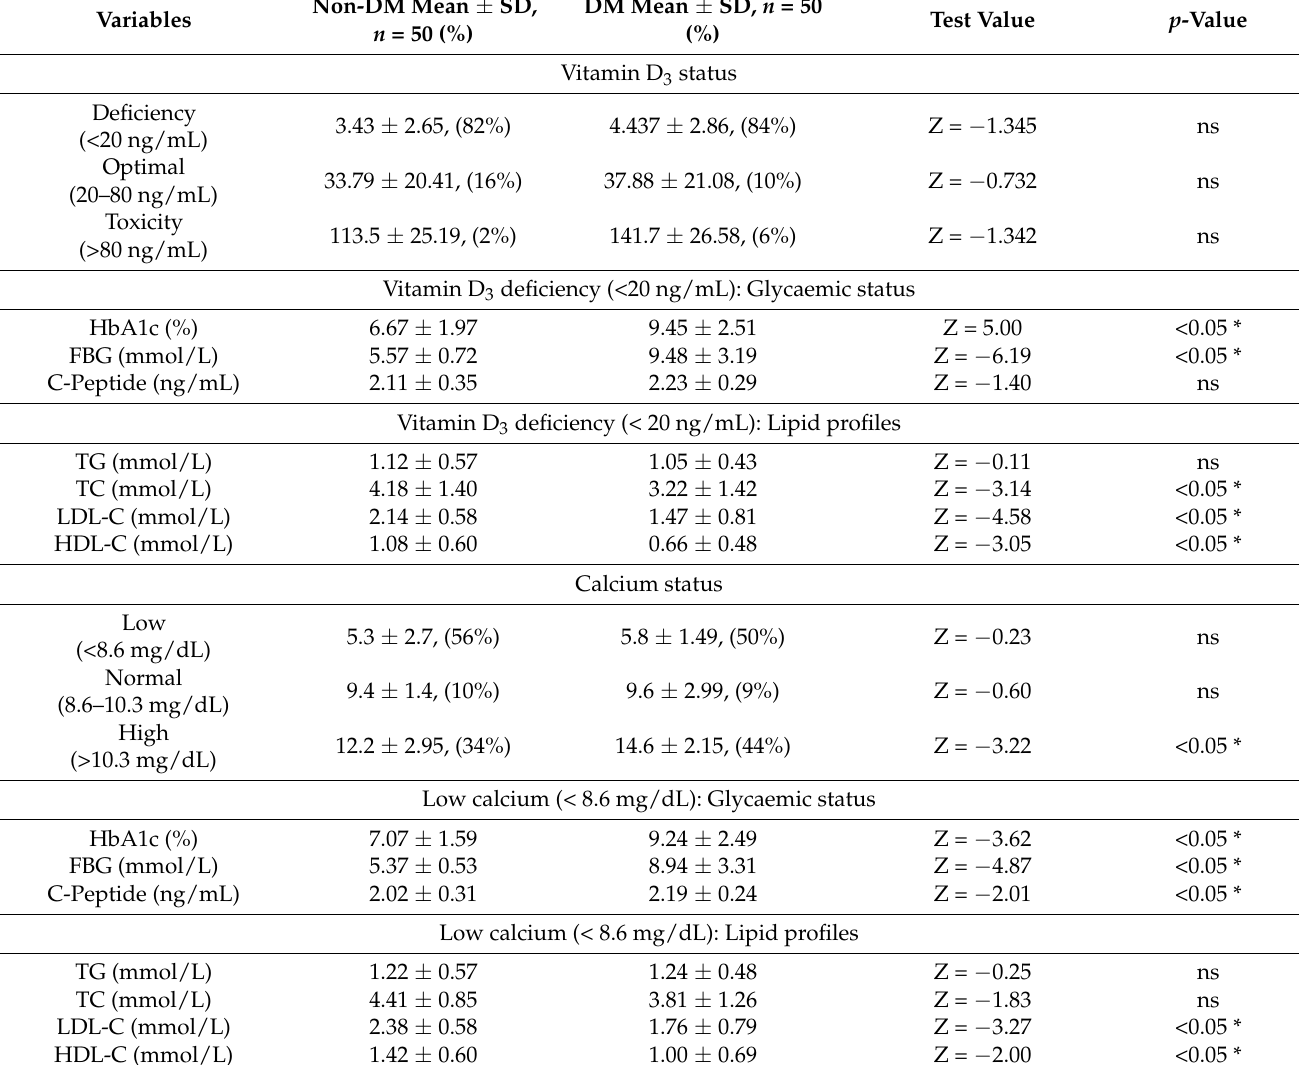
Table 4. Distribution of plasma vitamin D 3 and calcium levels in non-DM and DM groups determined using Independent